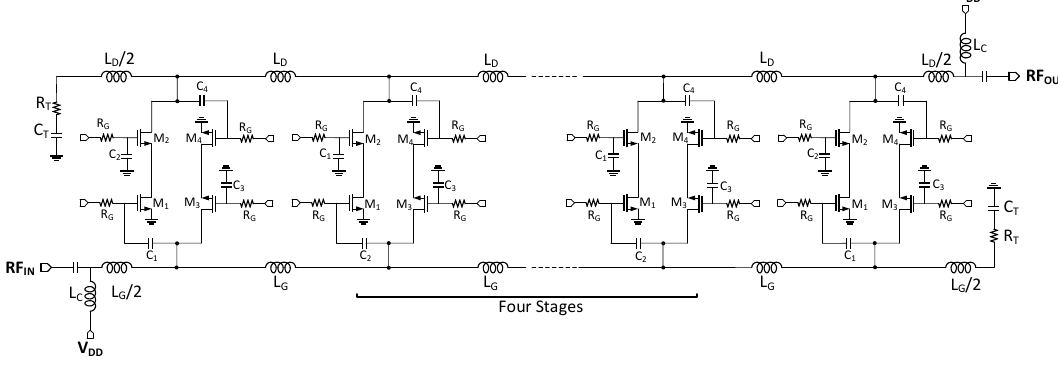
Figure 13. A circuit schematic of the proposed BDGA with six stages of gain cells.